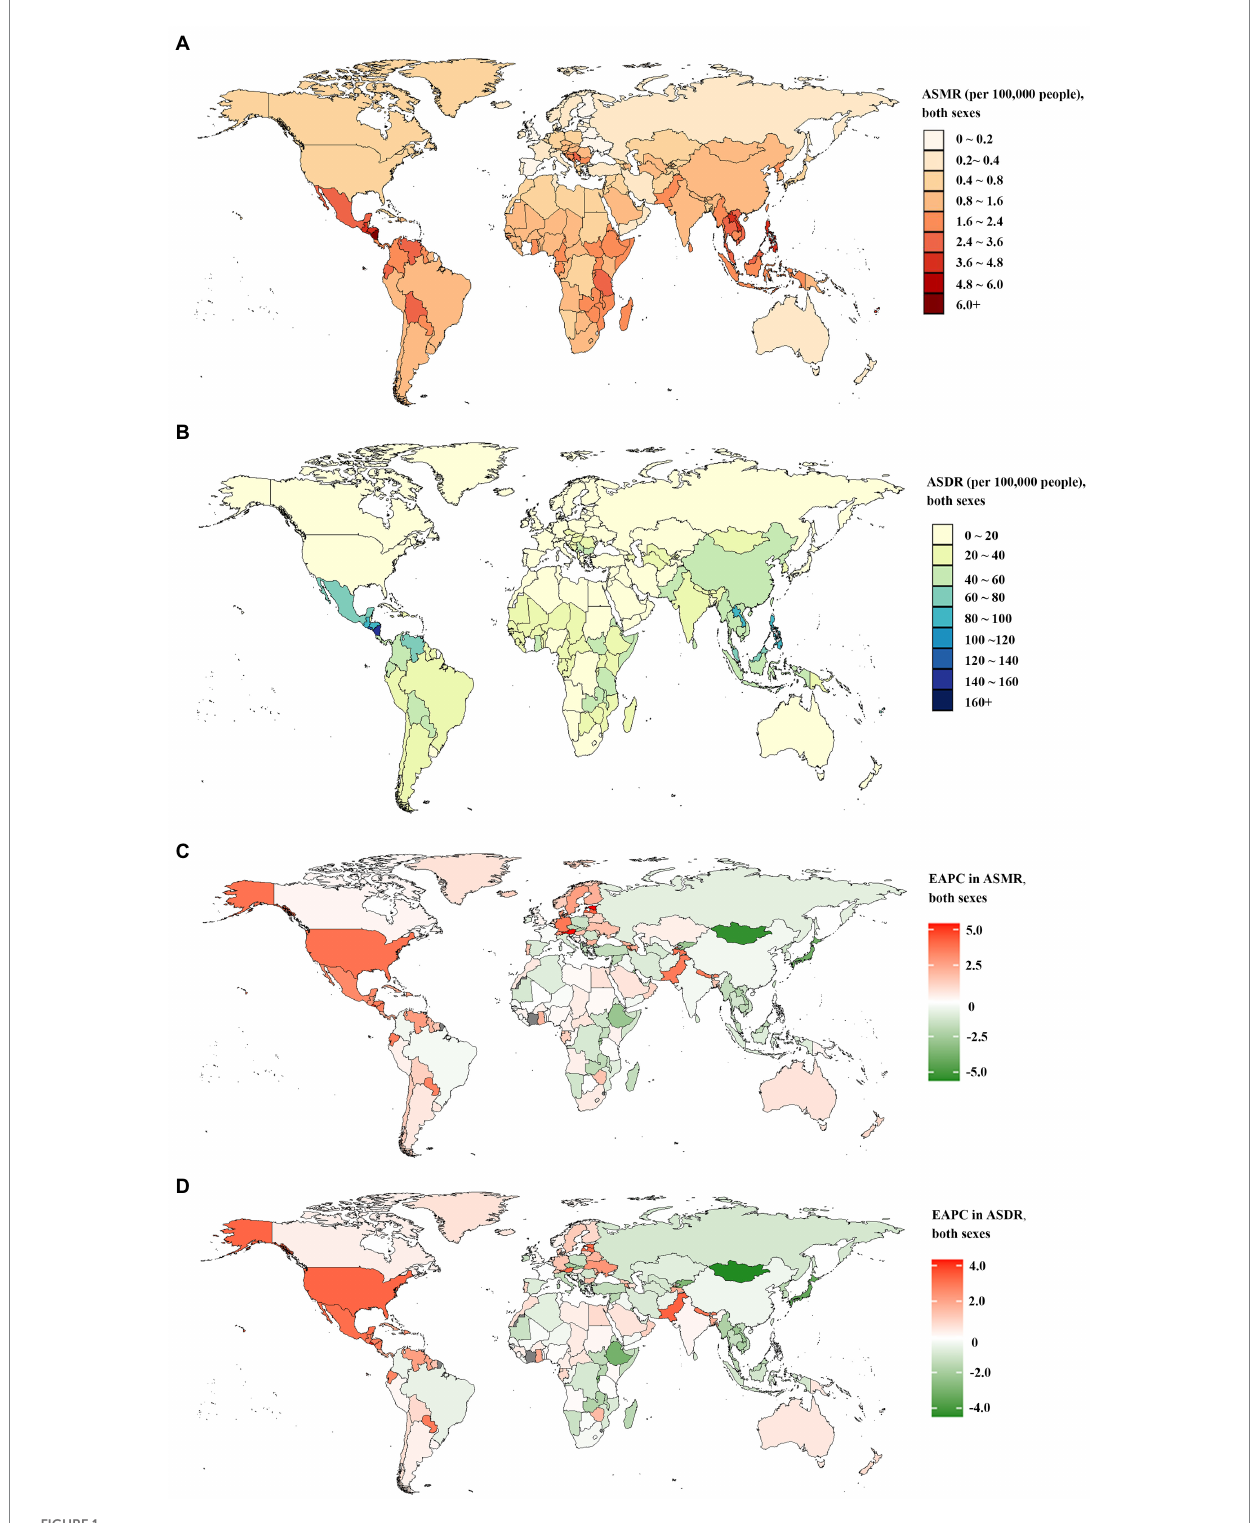
FIGURE 1 The global disease burden of chronic kidney disease attributable to high sodium intake for both sexes combined in 204 countries and territories. (A) The spatial distribution of chronic kidney disease ASMR attributable to high sodium intake in 2019. (B) The spatial distribution of chronic kidney disease ASDR attributable to high sodium intake in 2019. (C) The EAPC in chronic kidney disease ASMR attributable to high sodium intake from 1990 to 2019. (D) The EAPC in chronic kidney disease ASDR attributable to high sodium intake from 1990 to 2019. ASMR age-standardized mortality rate; DALYs, disability-adjusted life years; ASDR, age-standardized DALYs rate; EAPC, estimated annual